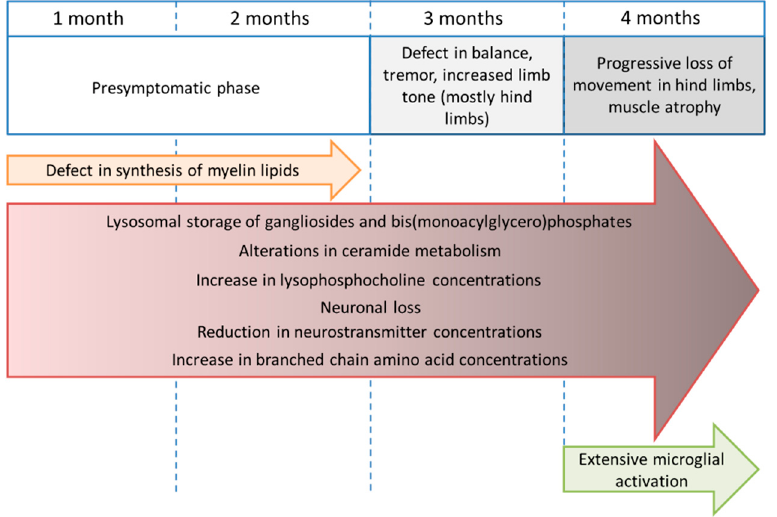
Figure 8. Representation of the metabolic changes observed in the metabolomic study of a mouse model of SD from one to four months of age, matched with the manifestations observed in this murine